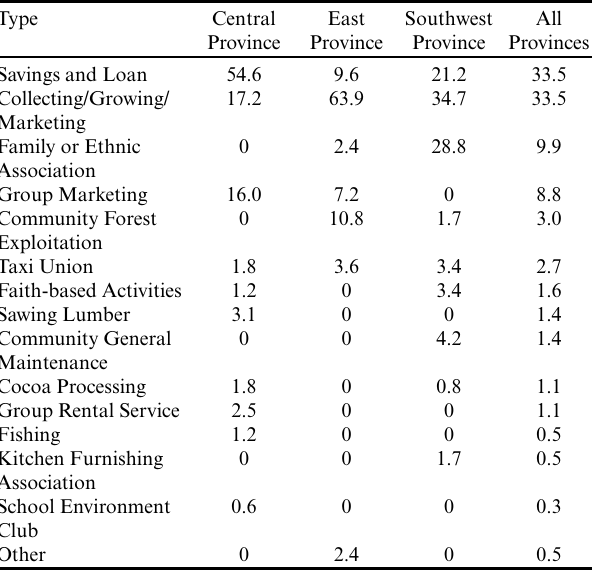
Table 2 . Types of local institutions present in villages within each province